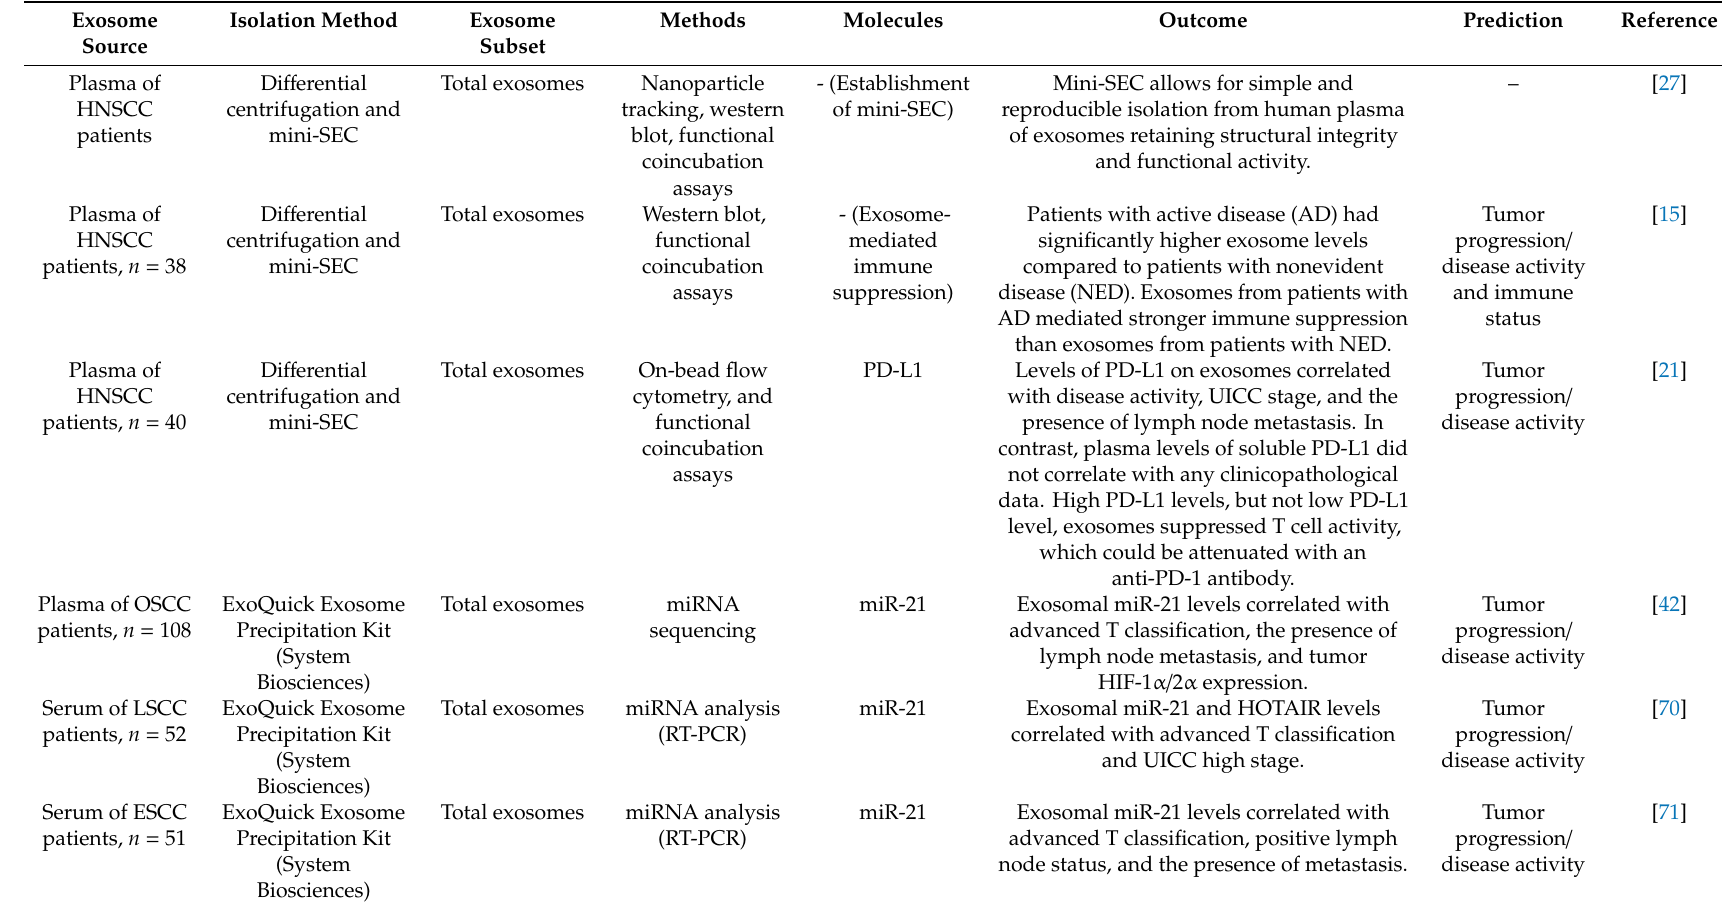
Table 3. Exosome studies involving